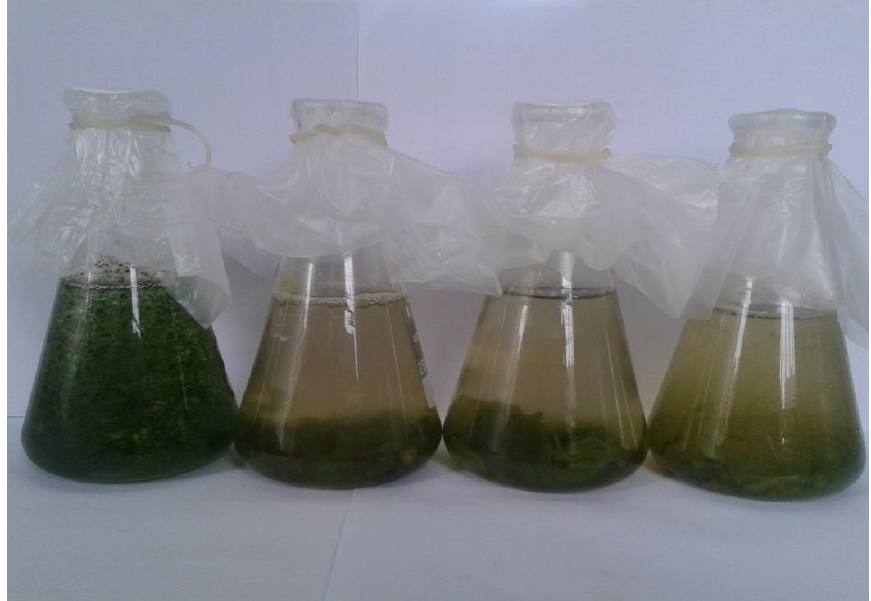
Figure 6. Effect of three addition methods with Phanerochaete chrysosporium on Turpin